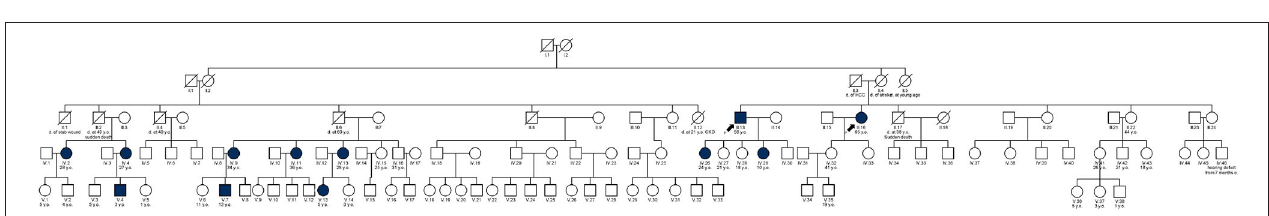
FIGURE 3 | Family tree (pedigree). The index case and his sister are shown with arrows.